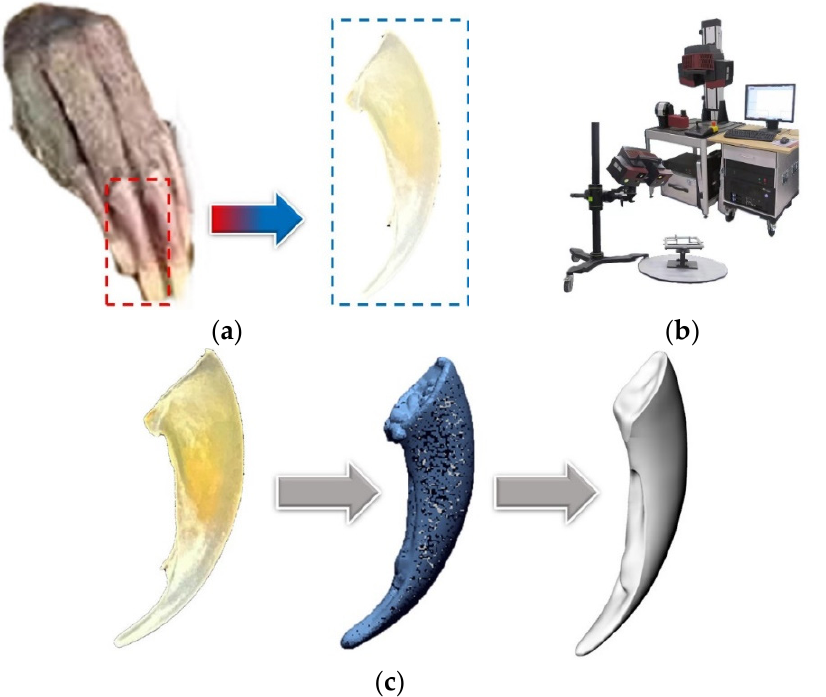
Figure 1. Bionic prototype and extraction optimization process. ( a ) Bionic prototype; ( b ) Bionic prototype extraction process; ( c ) 3D model optimization process.